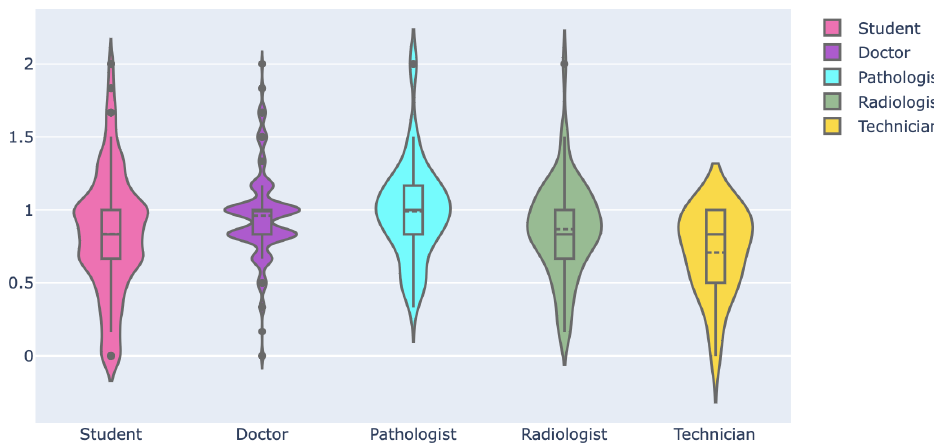
Figure 11. Familiarity scoring system.